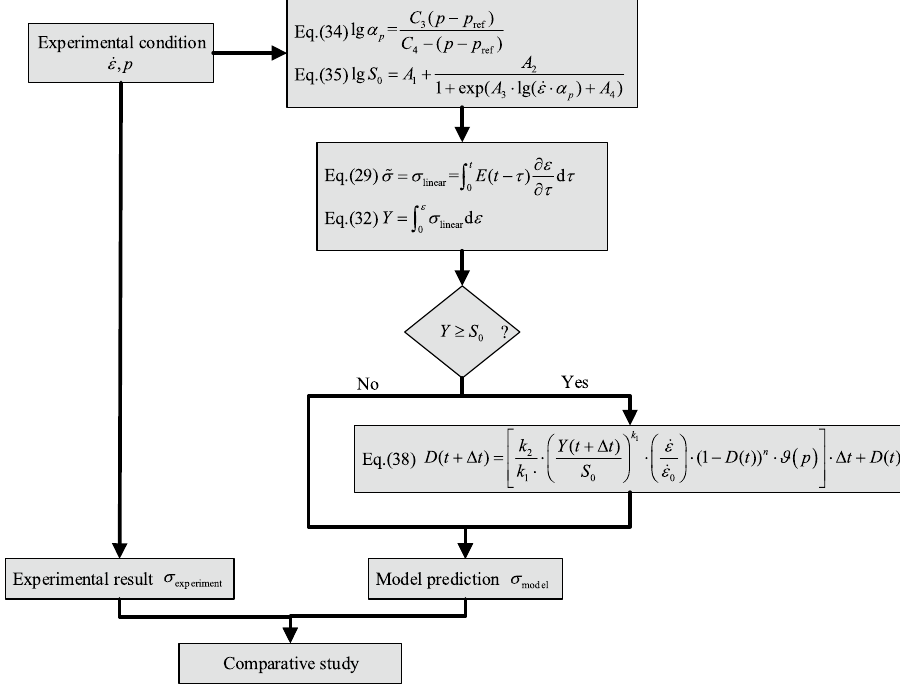
Figure 14. The validation process of constitutive